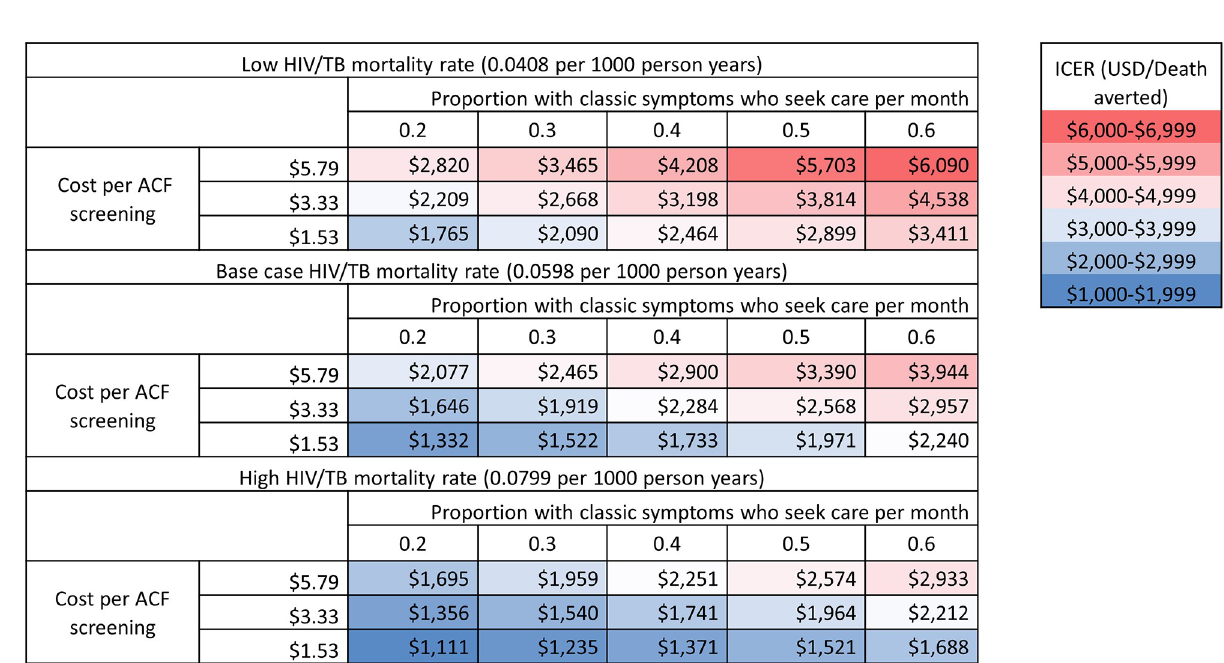
PLOS ONE | https://doi.org/10.1371/journal.pone.0256531 September 9,